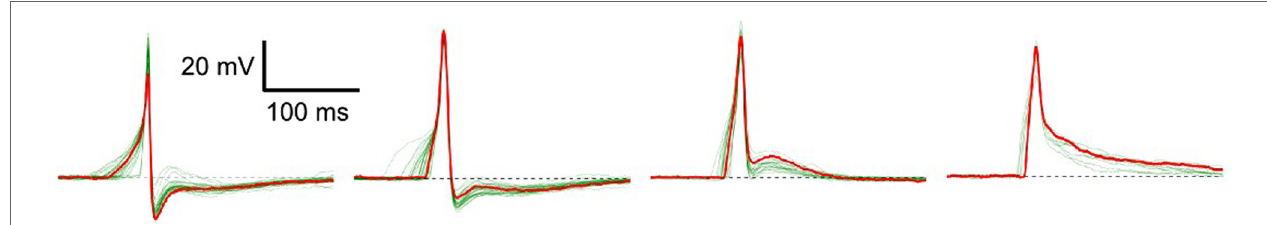
FIgURe 1 | Diversity in action potentials observed in detrusor smooth muscle cells. The green traces in each panel represent different instances of APs having a similar profile. A typical AP shape belonging to each group is highlighted in red.